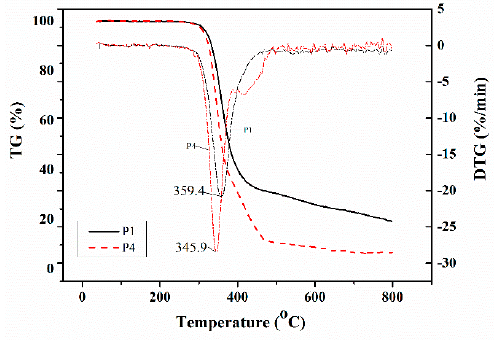
Figure 5. The thermal gravimetry (TG)/differential thermal gravimetry (DTG) curves of the waterborne fluoropolymer ( P1 ) and the acrylic polymer ( P4 ).